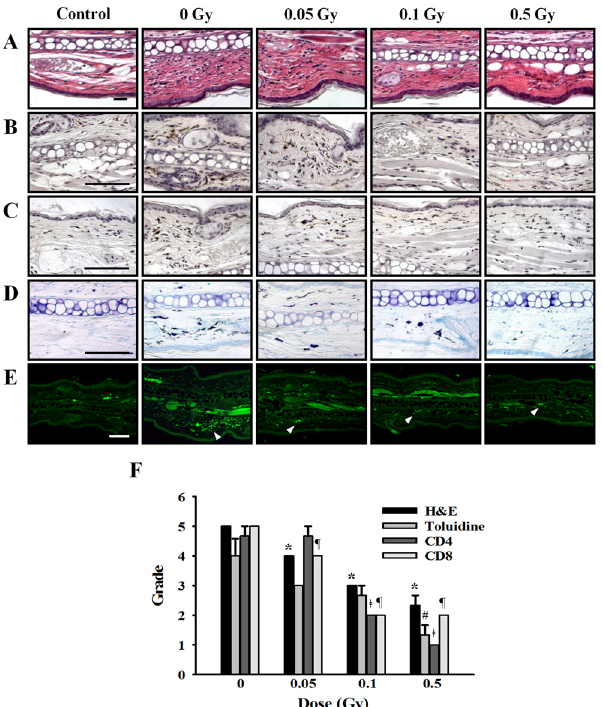
Fig 8. Effects of ionizing radiation on histological changes in ear tissue of passive cutaneous anaphylaxis model. Anti-DNP (20 ng) was injected intradermally in the left ear, whereas the right ear was injected with saline as a control. After 24 h, mice were irradiated with 0 – 0.5 Gy before injection of 100 μ g DNP-HAS via the tail vein. After 5 hr, sections of ear tissue were stained with H&E (A), immunohistochemistry for CD4 (B) and CD8 (C), toluidine blue (D), and Fc ε RI expression (E) observed at 400× magnification. Histological appearance was score for the presence of infiltrating cells (F). Bars = 100 μ m. * p < 0.05, # p < 0.05, ǂ p < 0.05, ¶ p < 0.05 versus the corresponding 0 Gy of H&E, Toluidine, CD4, and CD8,